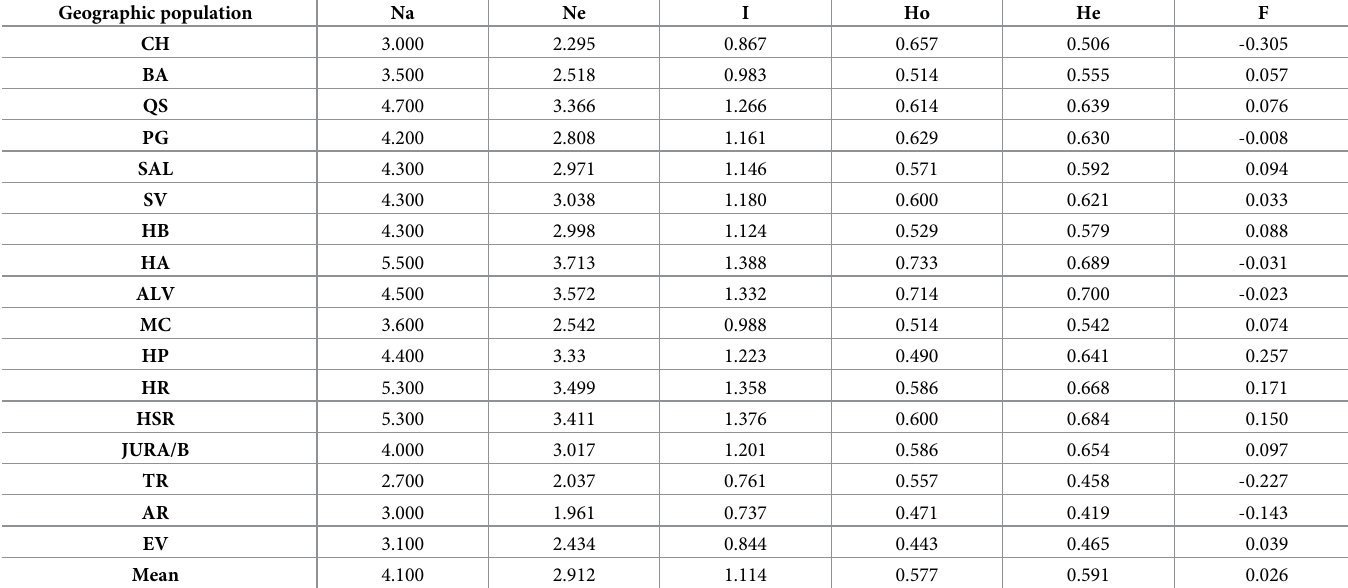
Table 3. Genetic diversity analyses of Cynara cardunculus from 17 populations. Geographic